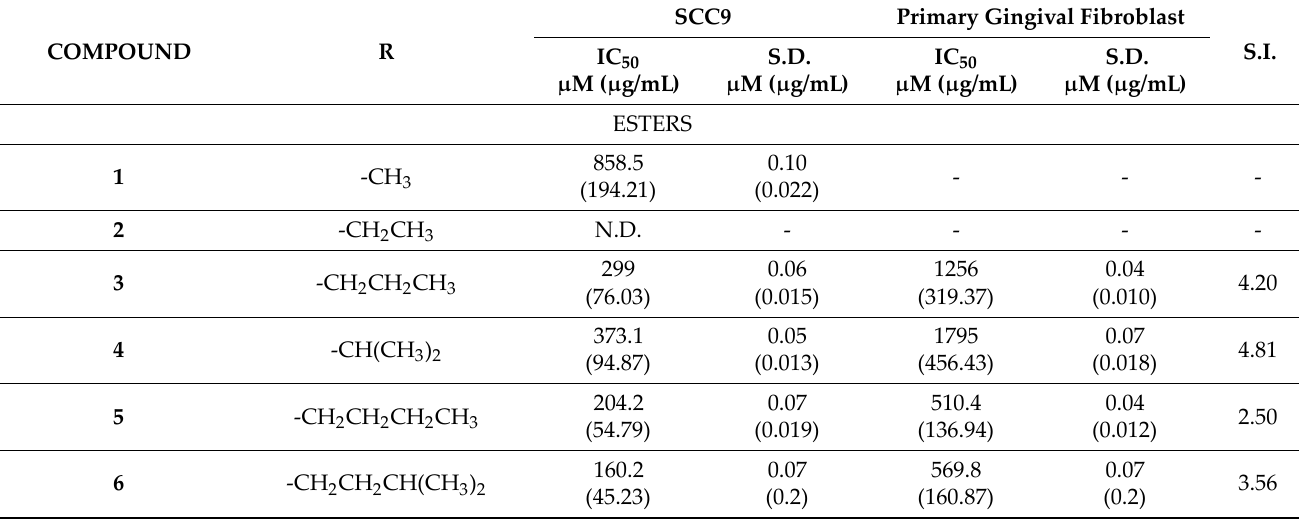
Table 1. IC 50 results for compounds 1 – 19